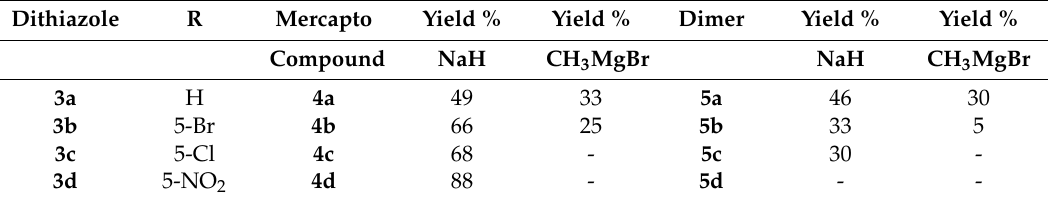
Table 2. Yields of conversion of 3-(1,2,3-dithiazol-5-ylidene)indololin-2-ones ( 3a – d ) into 2-mercapto-2-(2-